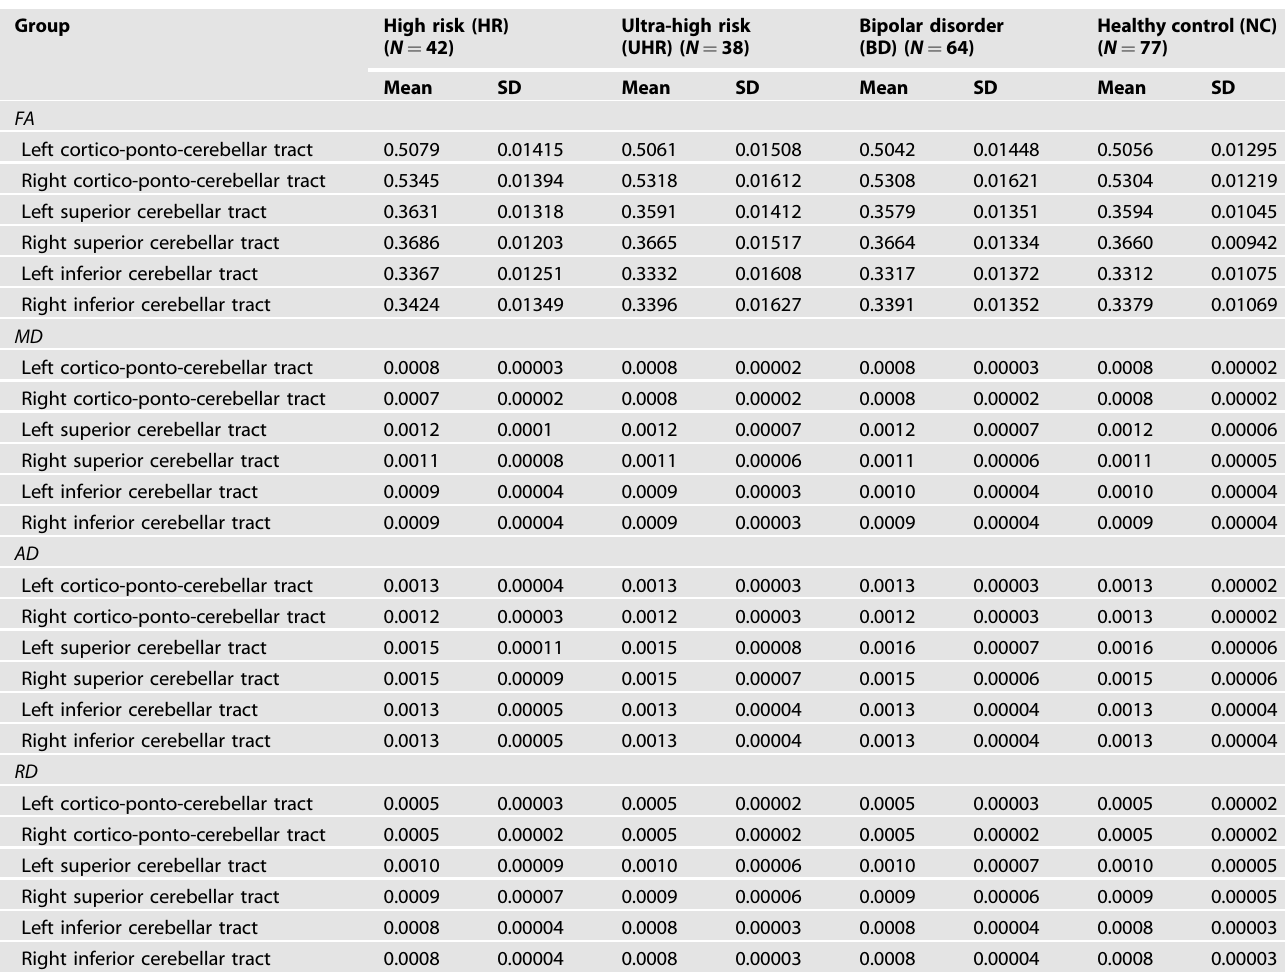
Table 2. Diffusivity measures for each group (normal healthy control, HR, URH, and BD). Group